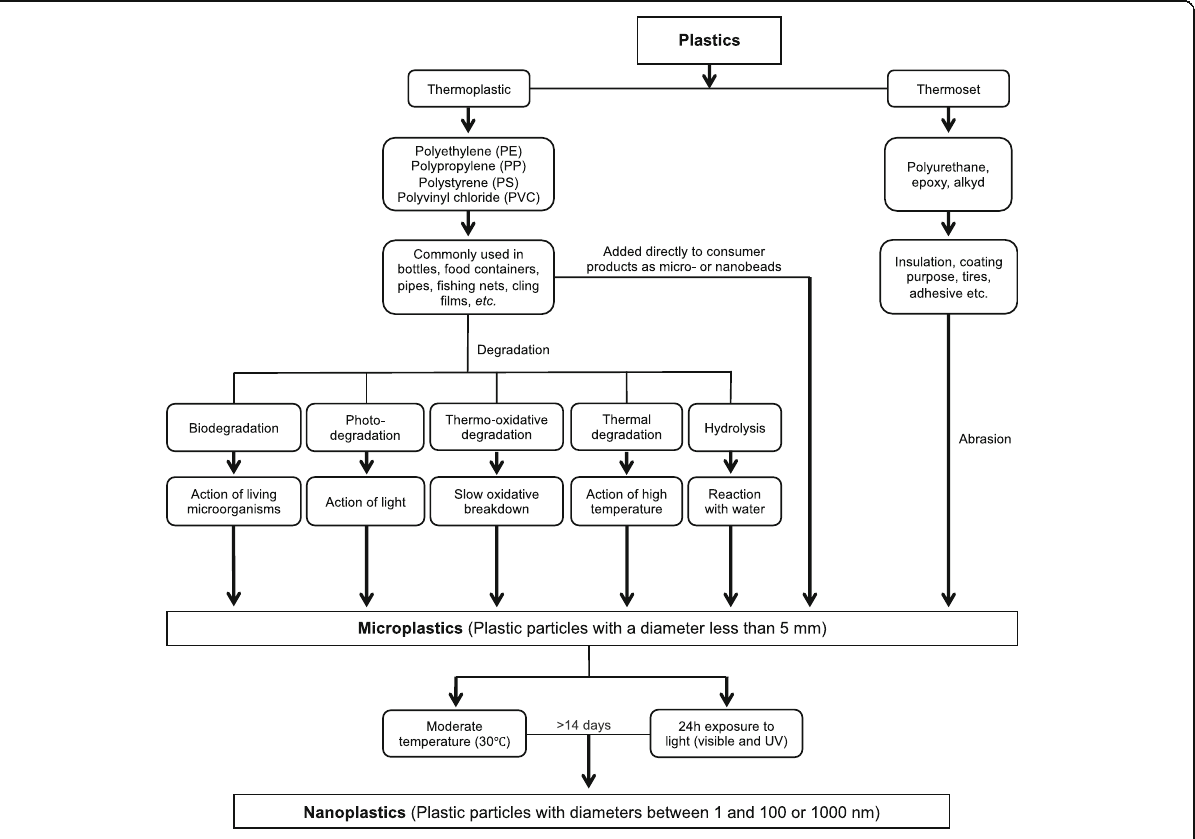
Fig. 1 A summary of possible environmental degradation pathway of plastics. This schematic is drawn based on [11,